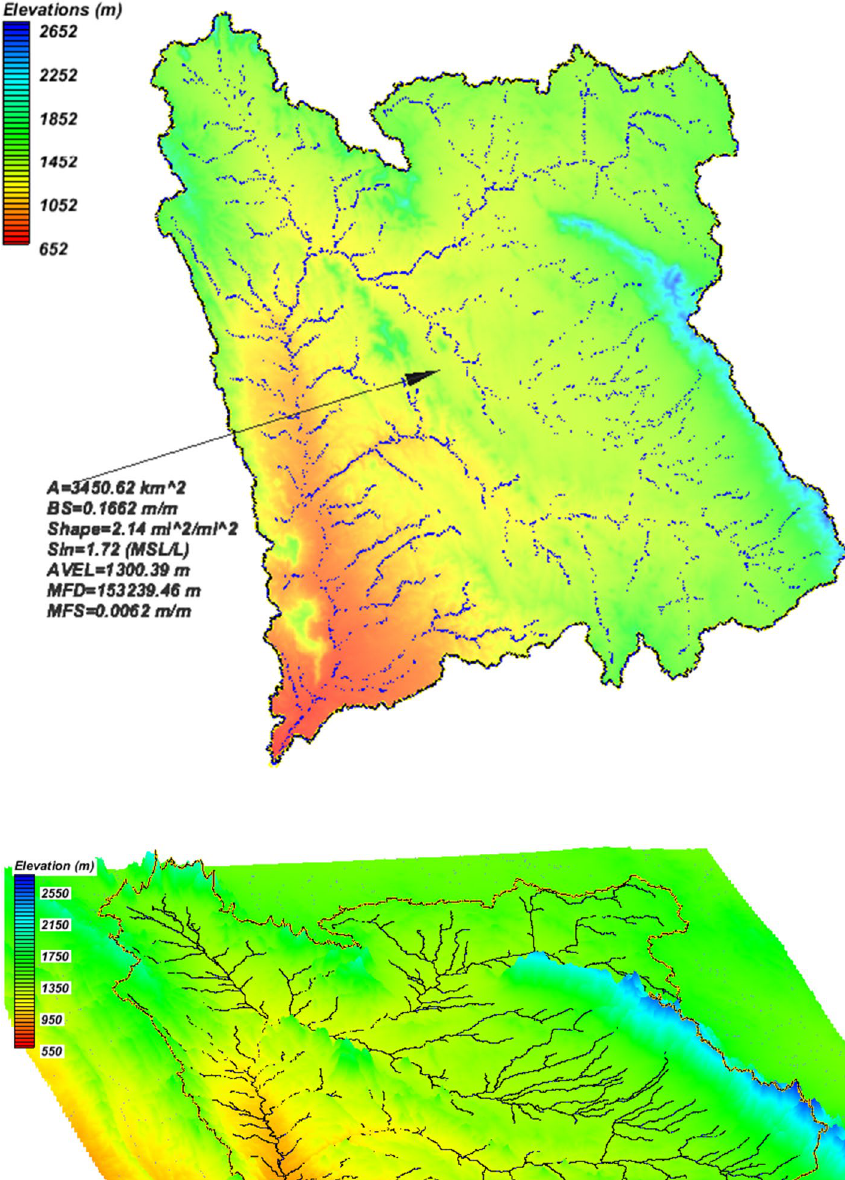
Fig. 5 Plan view of physi- ographical conceptual model of Karvandar River watershed